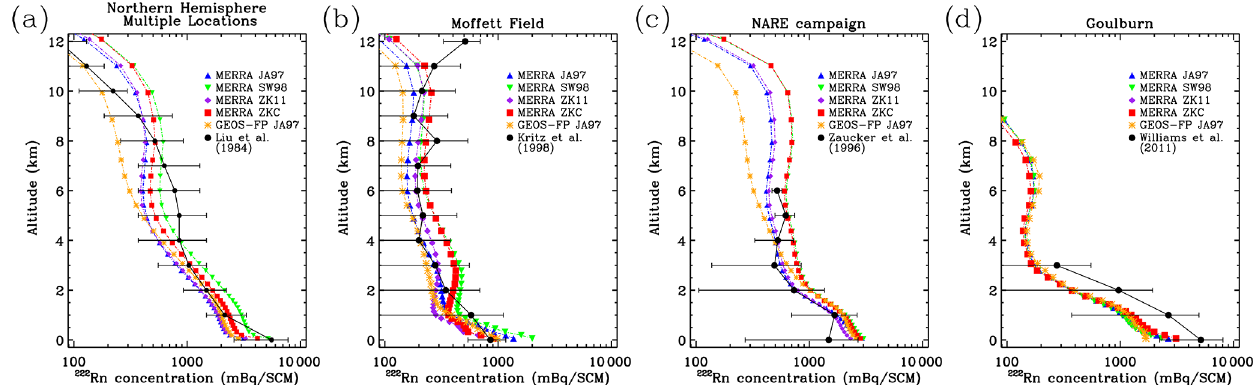
Figure 12. Comparison of vertical of 222 Rn profiles (mBq/SCM) simulated with four emission scenarios (simulations A1, A2, A3, and A4; see Table 2) with (a) an average profile compiled from 23 locations over the Northern Hemisphere continents (Liu et al., 1984); (b) an average summertime profile constructed from measurements at Moffett Field (37.4 ◦ N, 122 ◦ W), California (Kritz et al., 1998); (c) an average summertime profile from measurements on the east coast of Canada during the 1993 NARE campaign (Zaucker et al., 1996); and (d) an averaged profile measured in May of 2006–2008, at Goulburn (34.8 ◦ S, 149.7 ◦ E), New South Wales, Australia (Williams et al., 2011). In panel (a) , more than half of the observed profiles reach up to 6–12km. Horizontal bars indicate the standard deviations of the observed 222 Rn